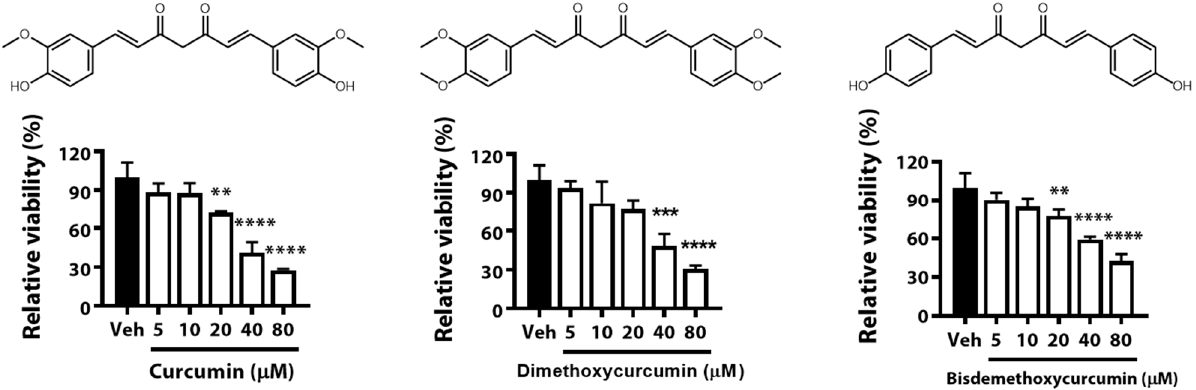
Figure 1. Molecular structures and cytotoxicity of curcumin (CUR), dimethoxycurcumin (DMC), and bisdemethoxycurcumin (BDMC). Viability of B16F10 cells with the treatment of 0, 5, 10, 20, 40, 80 µ M of CUR, DMC, and BDMC. Data are presented as mean ± standard deviation (SD). Significant differences are expressed by the symbols **, ***, and **** as ** p < 0.01, *** p < 0.001, and **** p < 0.0001 compared with control.